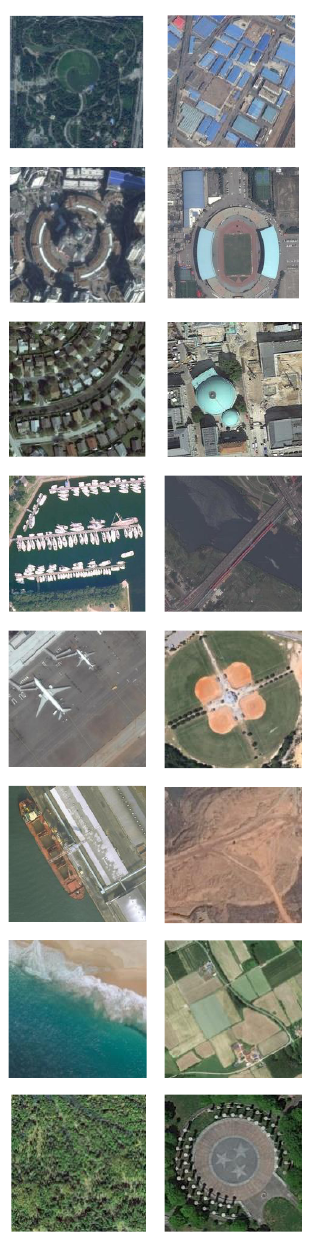
Figure 7. Some images and two image-captioning pairs in RSICD data sets. It can be observed that the large scene has various objects and the captions are